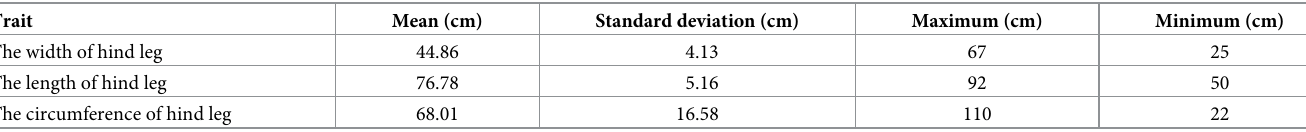
Table 1. Descriptive statistics for hind-leg measurements of experimental